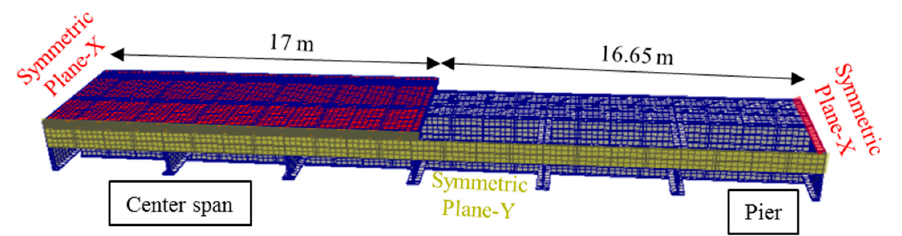
Figure 17. FE model of one-fourth of a bridge span. Table 3. Mixture designs used for parametric study.